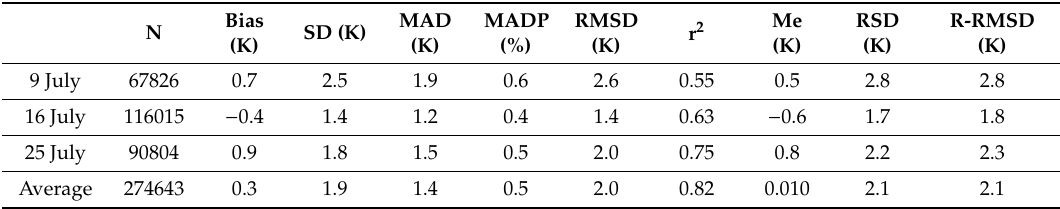
Table 3. Quantitative analysis of the differences plotted in Figure 9. Statistical metrics as defined in Table 2.